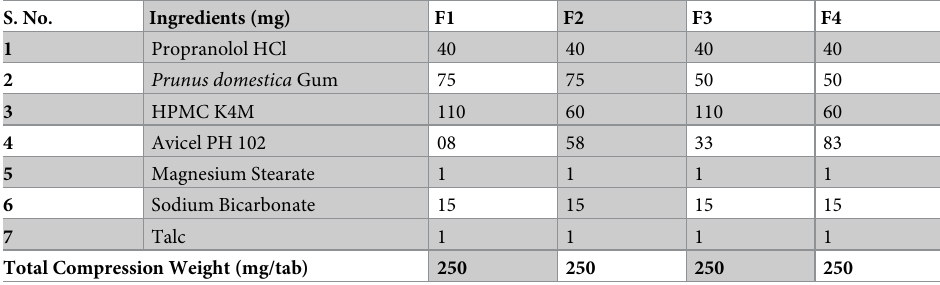
Table 2. Formulation composition of propranolol HCl 40 mg tablets floating tablets.